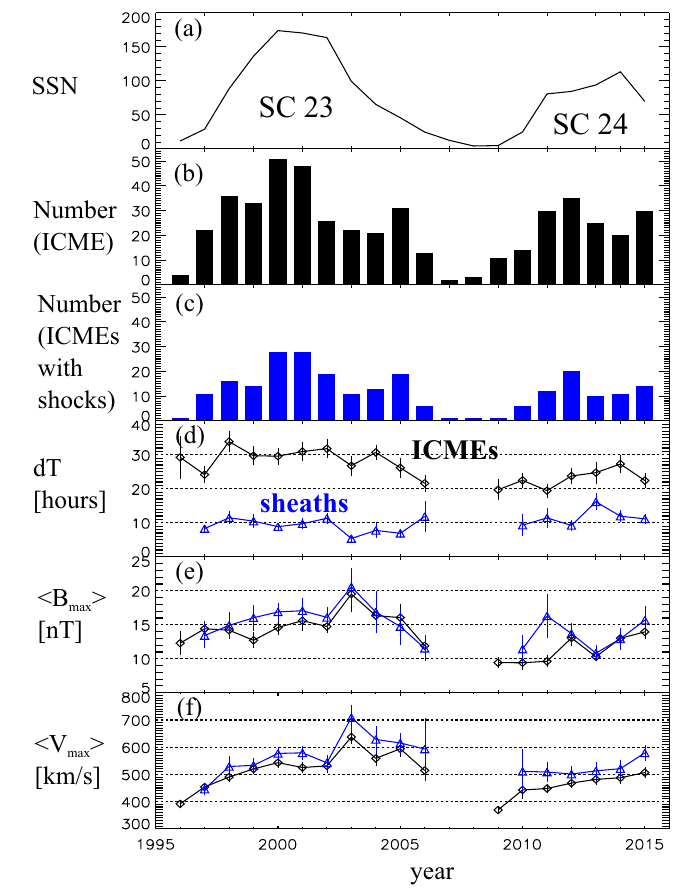
Fig.22 AnnualvariationsintheICME(black)andsheath(blue)occurrencerateandproperties.Thepanels show a the yearly mean sunspot number from Solar Influences Data Center (http://sidc.oma.be), and the annual number of b ICMEs, and c the ICMEs that drove shocks, the annual means of d the duration, and the peak e magnetic field, and f speed in ICMEs (black) and sheaths (blue). The error bars give the standard deviations.Theyearswhenthreeorlesseventsoccurredareexcludedfrompanels( d – f ).TheICMEintervals are from the Richardson and Cane ICME list. The sheath intervals are determined using the ICME leading edge times given in Richardson and Cane list and the shocks time from the Interplanetary Shock Database of the University of Helsinki (www.ipshocks.fi/). Note that here we consider as “sheaths” only the